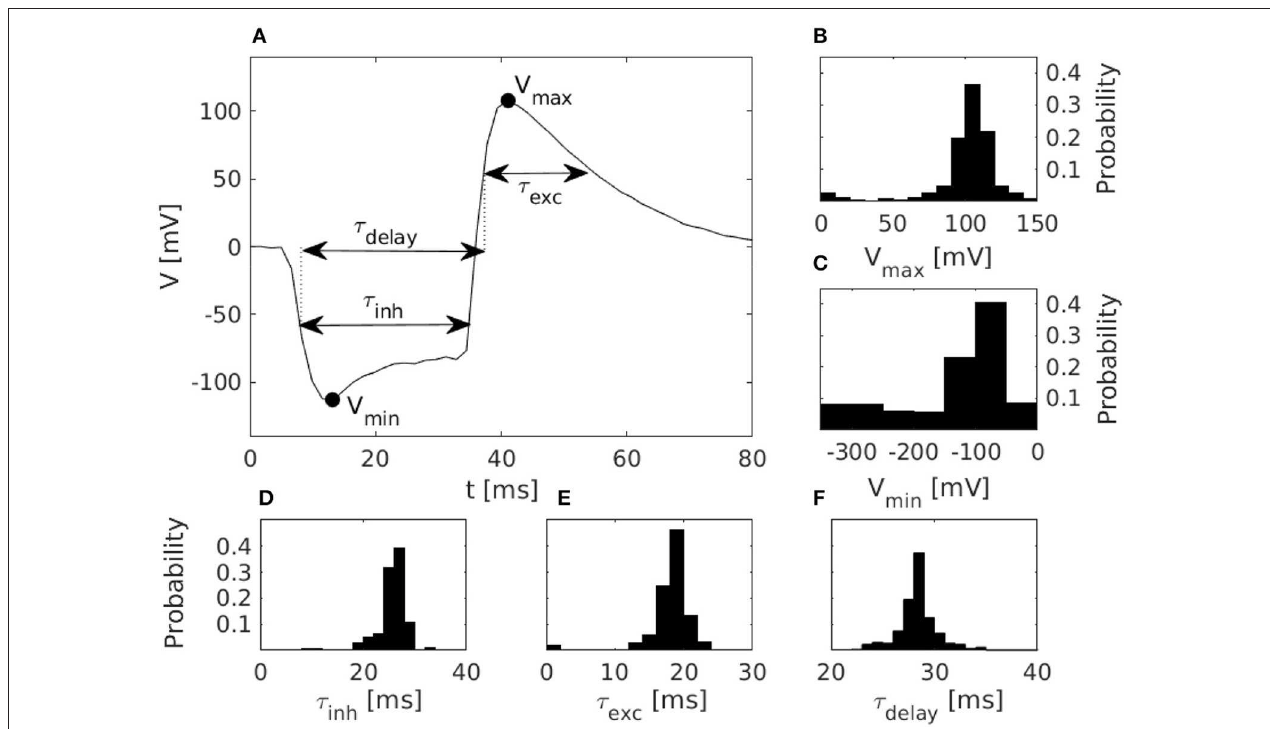
FIGURE 3 | Characteristics of disynaptic delay elements configured in the DYNAP-SE neuromorphic processor. (A) Postsynaptic membrane potential vs. time, illustrating the delayed excitation resulting from a presynaptic pulse. (B) Distribution of the maximum measured membrane potential, V max , resulting from a presynaptic pulse. (C) Similarly, the distribution of the minimum measured membrane potential, V min . (D) Distribution of the inhibitory timescale, τ inh , defined as the full width at half minimum. (E) Distribution of the excitatory timescale, τ exc , defined as the full width at half maximum. (F) Distribution of the delay time, τ delay , defined as the duration from the onset of τ inh to the offset of τ exc . The distributions in panels (B–F) were obtained via characterization of one DYNAP-SE core, comprising, in parallel, one disynaptic delay element on each of the 256 neurons, with biases configured according to Table 1 .